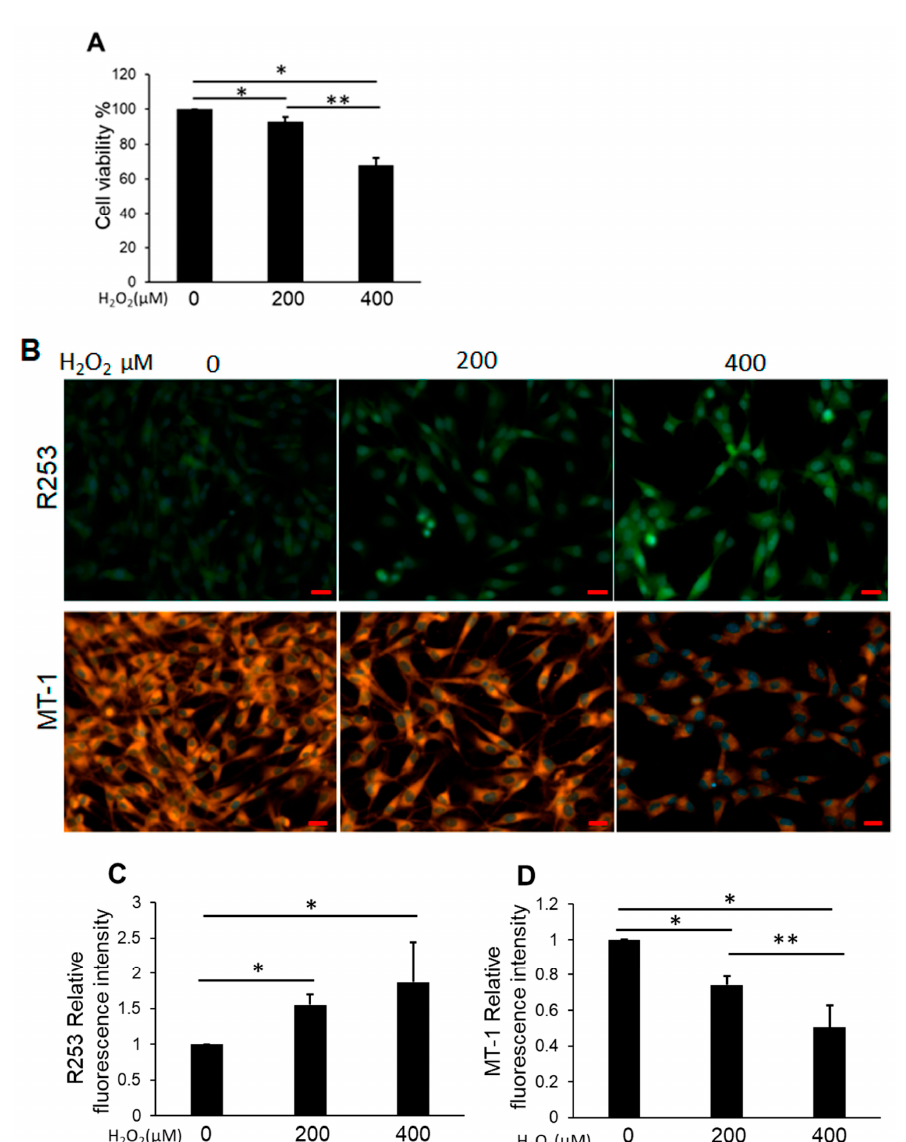
Figure 2. ( A ) Cell viability of H 2 O 2 -treated NP cells. Cells were cultured in DMEM with between 200 and 400 μ M H 2 O 2 for 24 h. Data are the means ± SD n = 4. * p < 0.05, ** p < 0.05. ( B ) The upper row of the figure represents the ROS production monitored using R253 (green) and the lower row is the mitochondrial membrane potential monitored using MT-1 (orange). The nucleus was detected by Hoechst 33342 reagent (blue). The detection of ROS production increased under H 2 O 2 treatment, and the detection of MT-1 decreased. Scale bars = 20 μ m. ( C ) Quantitative data of ROS production (R253). Data are the means ± SD n = 3, * p < 0.05. ( D ) Quantitative data of the mitochondrial membrane potential (MT-1). Data are the means ± SD n = 3, * p < 0.05, ** p < 0.05.